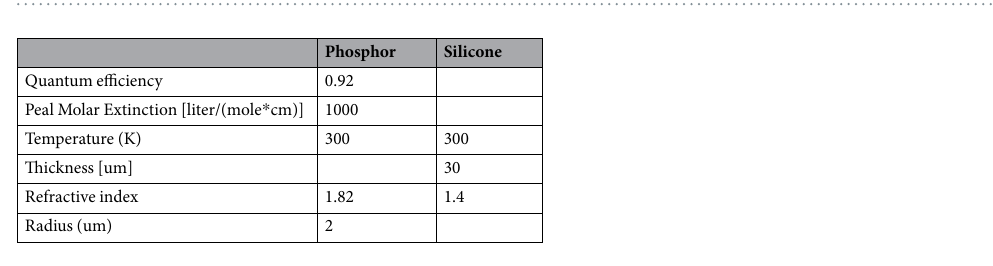
Table 2. Simulation parameters used in TracePro for silicone and